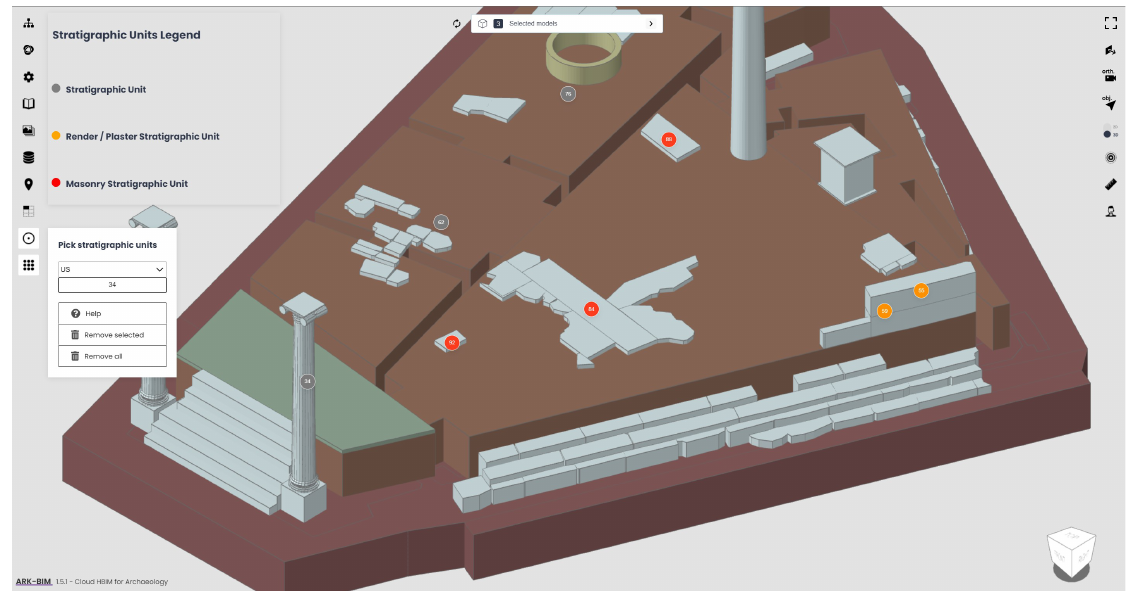
Figure 12. Part of source code related to the Pick Stratigraphic Units plugin (the complete code is on the ARK-BIM website).